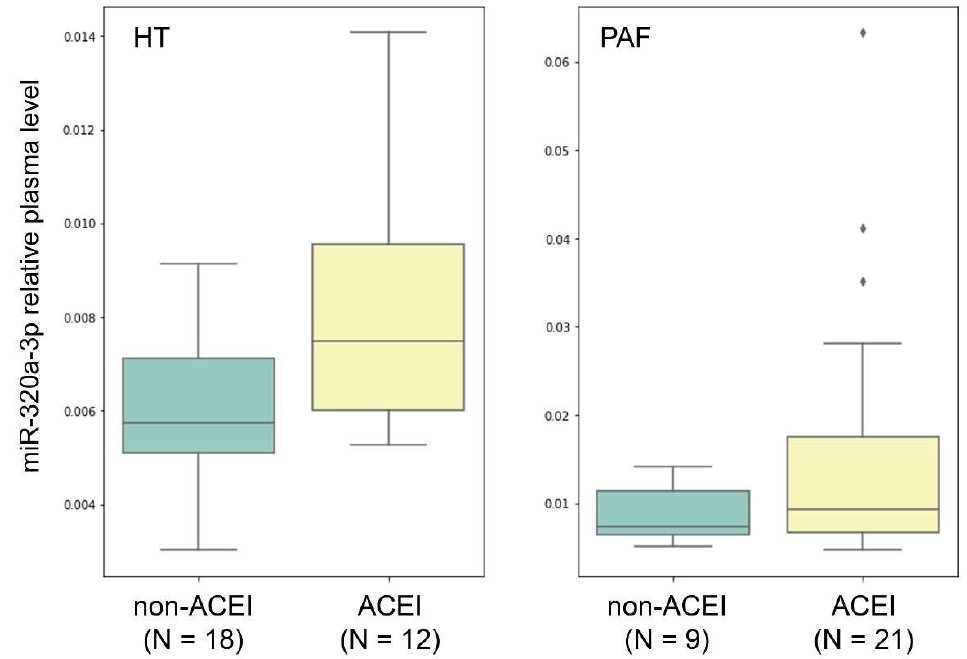
Figure 4. Distribution of miR-320a-3p relative plasma levels in the study sample groups HT (hypertensive patients without AF, N = 30) and PAF (patients with paroxysmal atrial fibrillation) in patients with and without angiotensin-converting enzyme inhibitors (ACEI) treatment. The boxplots represent the median and interquartile ranges (IQR) in the box, minimum and maximum values in the “whiskers”, and outliers in the rhombic dots.